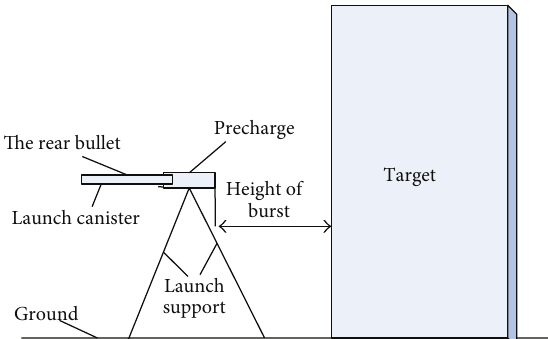
Figure 2: Schematic diagram of breaking and blasting large boulder with EBBLB.